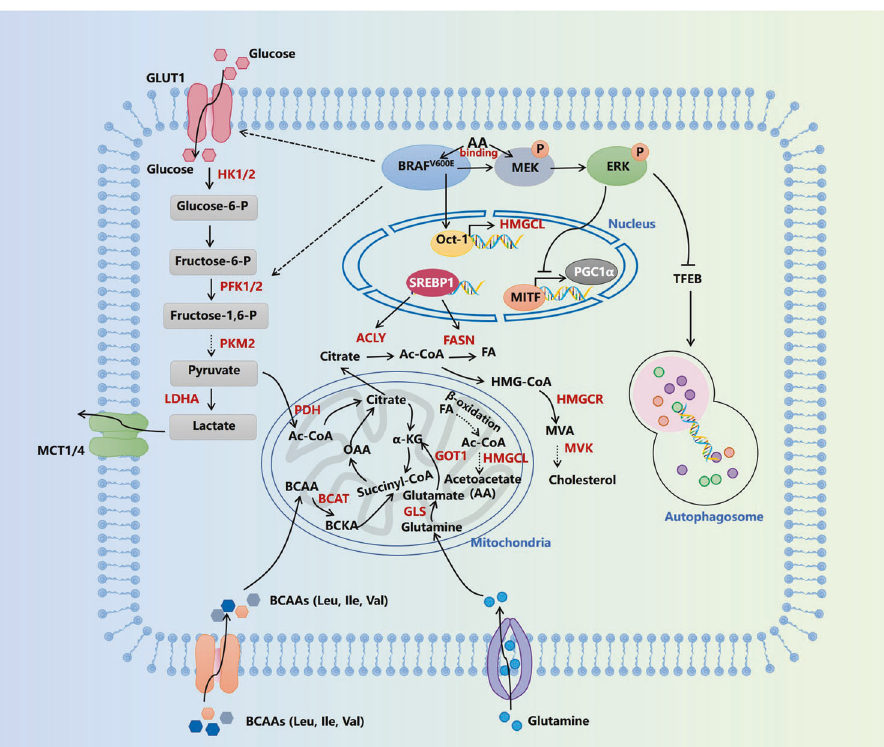
Fig. 6 Signal pathways of metabolic reprogramming in melanoma. AA acetoacetate, ACLY ATP-citrate lyase, BCAT branched-chain amino acid transaminase, BCKA branched-chain keto acids, FA fatty acid, FASN fatty acid synthase, GLS glutaminase, GLUT1 glucose transporter type 1, GOT1 glutamicoxaloacetic transaminase 1, HK1/2 hexokinase 1/2, HMGCL 3-hydroxy-3-methylglutaryl-CoA lyase, HMGCR 3-hydroxy-3- methylglutaryl-CoA reductase, LDHA lactate dehydrogenase A, MCT1/4 monocarboxylate transporter, MVA mevalonate, MVK mevalonate kinase, OAA oxaloacetate, PDH pyruvate dehydrogenase, PFK1/2 phosphofructokinase 1/2, PKM2 pyruvate kinase M, SREBP-1 sterol regulatory element-binding transcription factor 1, TFEB transcription factor